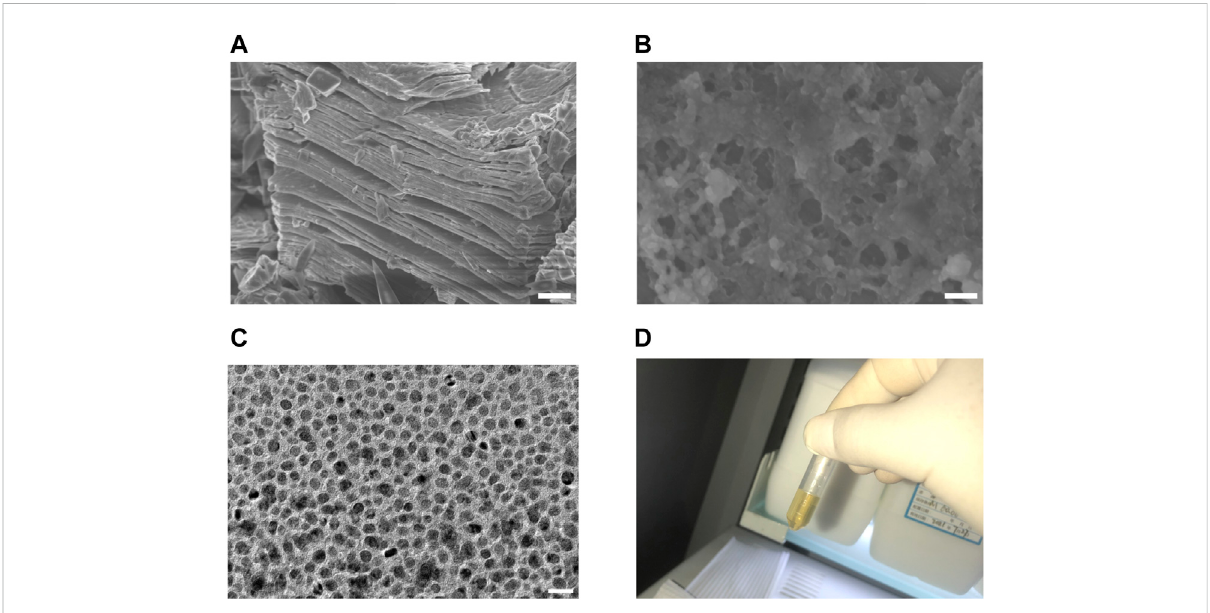
FIGURE 2 The preparation and characterization of NMQDs-Ti 3 C 2 Tx (A) SEM image of MXene-Ti 3 C 2 Tx. Scale bar: 2 μ m. (B) SEM image of MXene-Ti 3 C 2 Tx after microexplosion. Scale bar: 200 nm (C) TEM image of NMQDs-Ti 3 C 2 Tx. Scale bar: 20 nm. (D) the aqueous solution of NMQDs-Ti 3 C 2